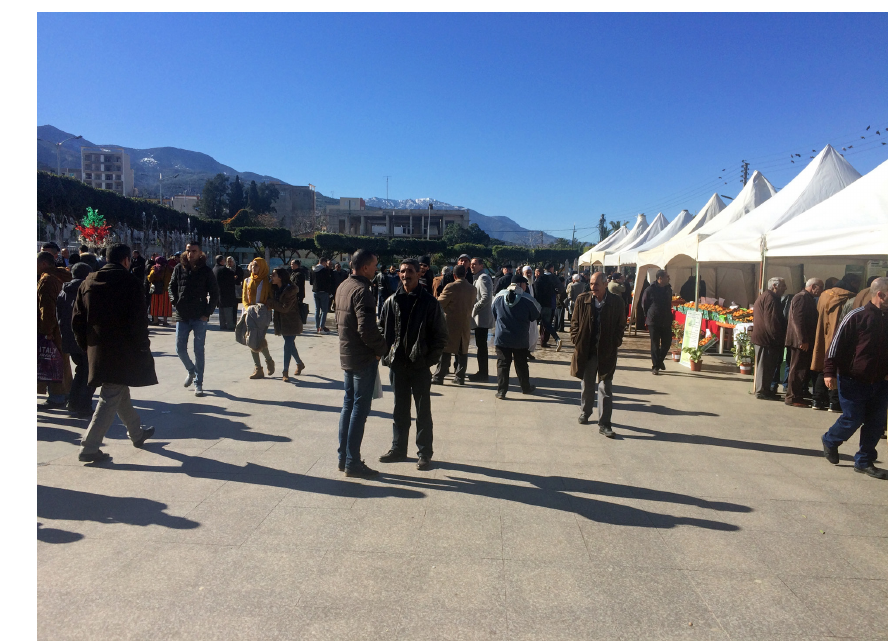
Fig. 2. Blida’s liberty Square, support for activities related to experiential